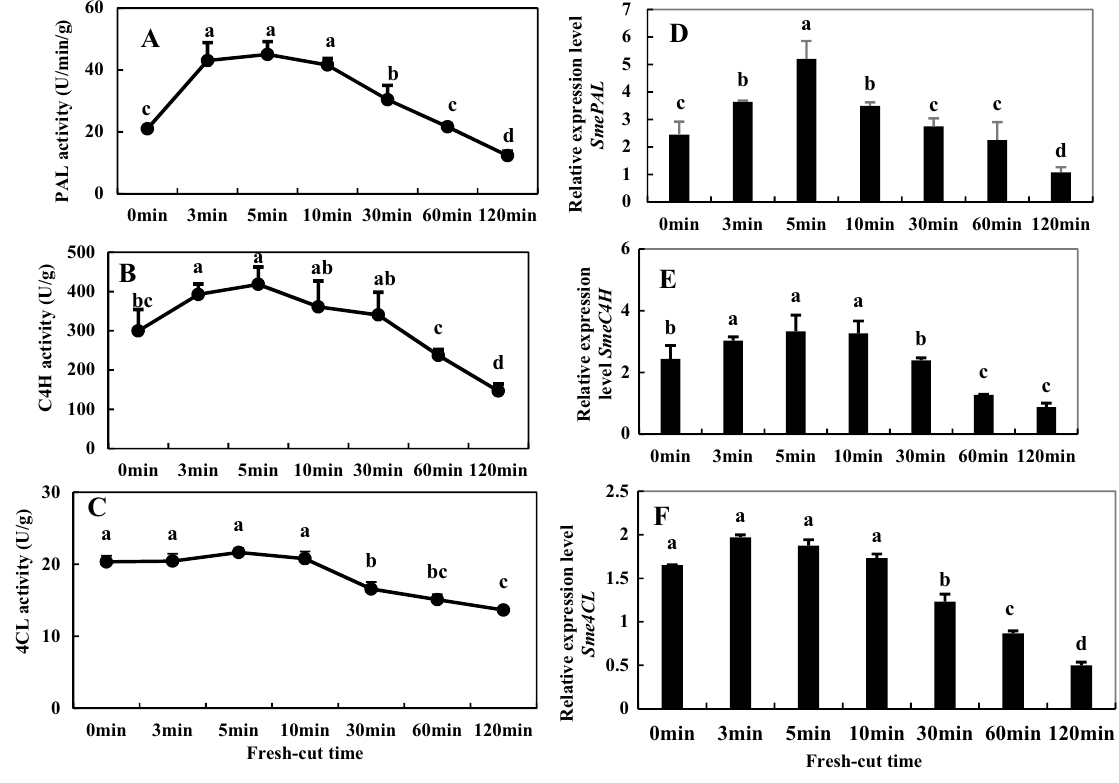
Figure 10. Activities of phenylalanine ammonium lyase (PAL) ( A ), cinnamate-4-hydroxylase (C4H) ( B ), and 4-coumarate coenzyme A ligase (4CL) ( C ) and the gene expression levels of SmePAL ( D ), SmeC4H ( E ), and Sme4CL ( F ) of fresh-cut eggplant. Data represent the means of three replicates and their standard